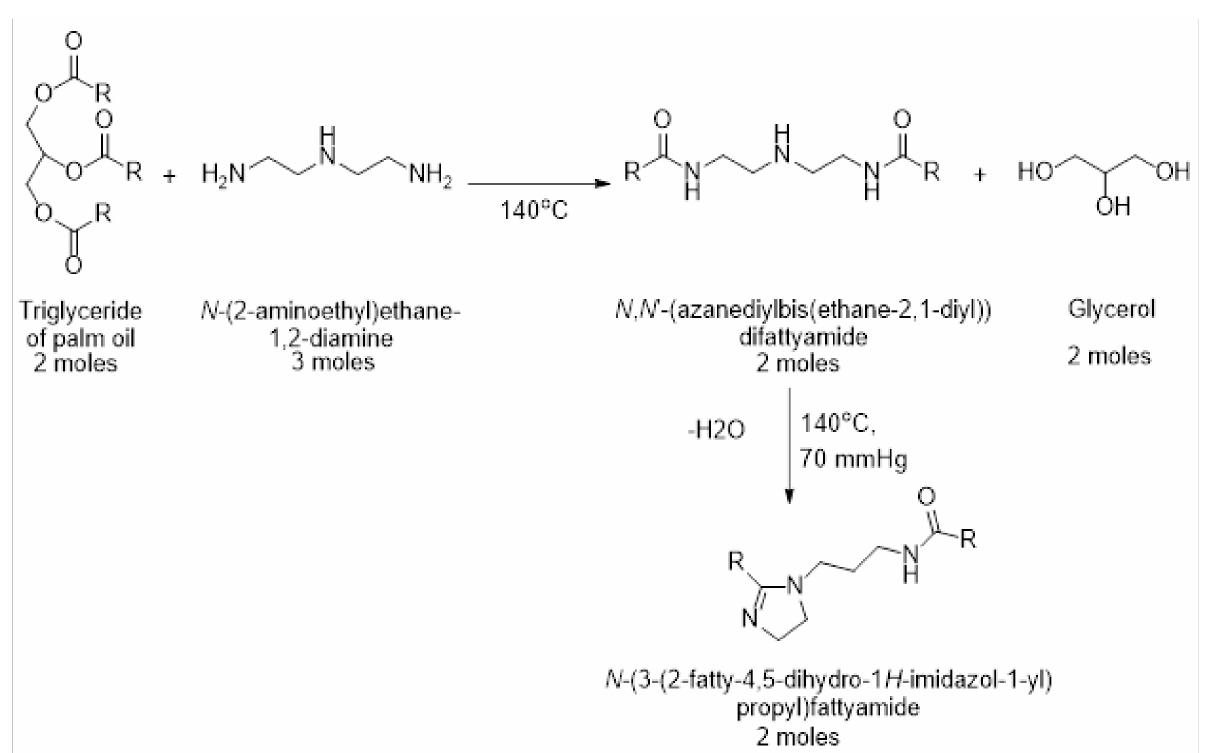
Figure 1. Synthesis of gemini surfactant imidazoline type. R= alkyl chains of fatty acids of mango seed